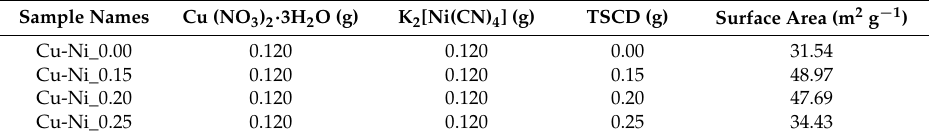
Table 1. Synthetic conditions of the various 2D Cu-Ni